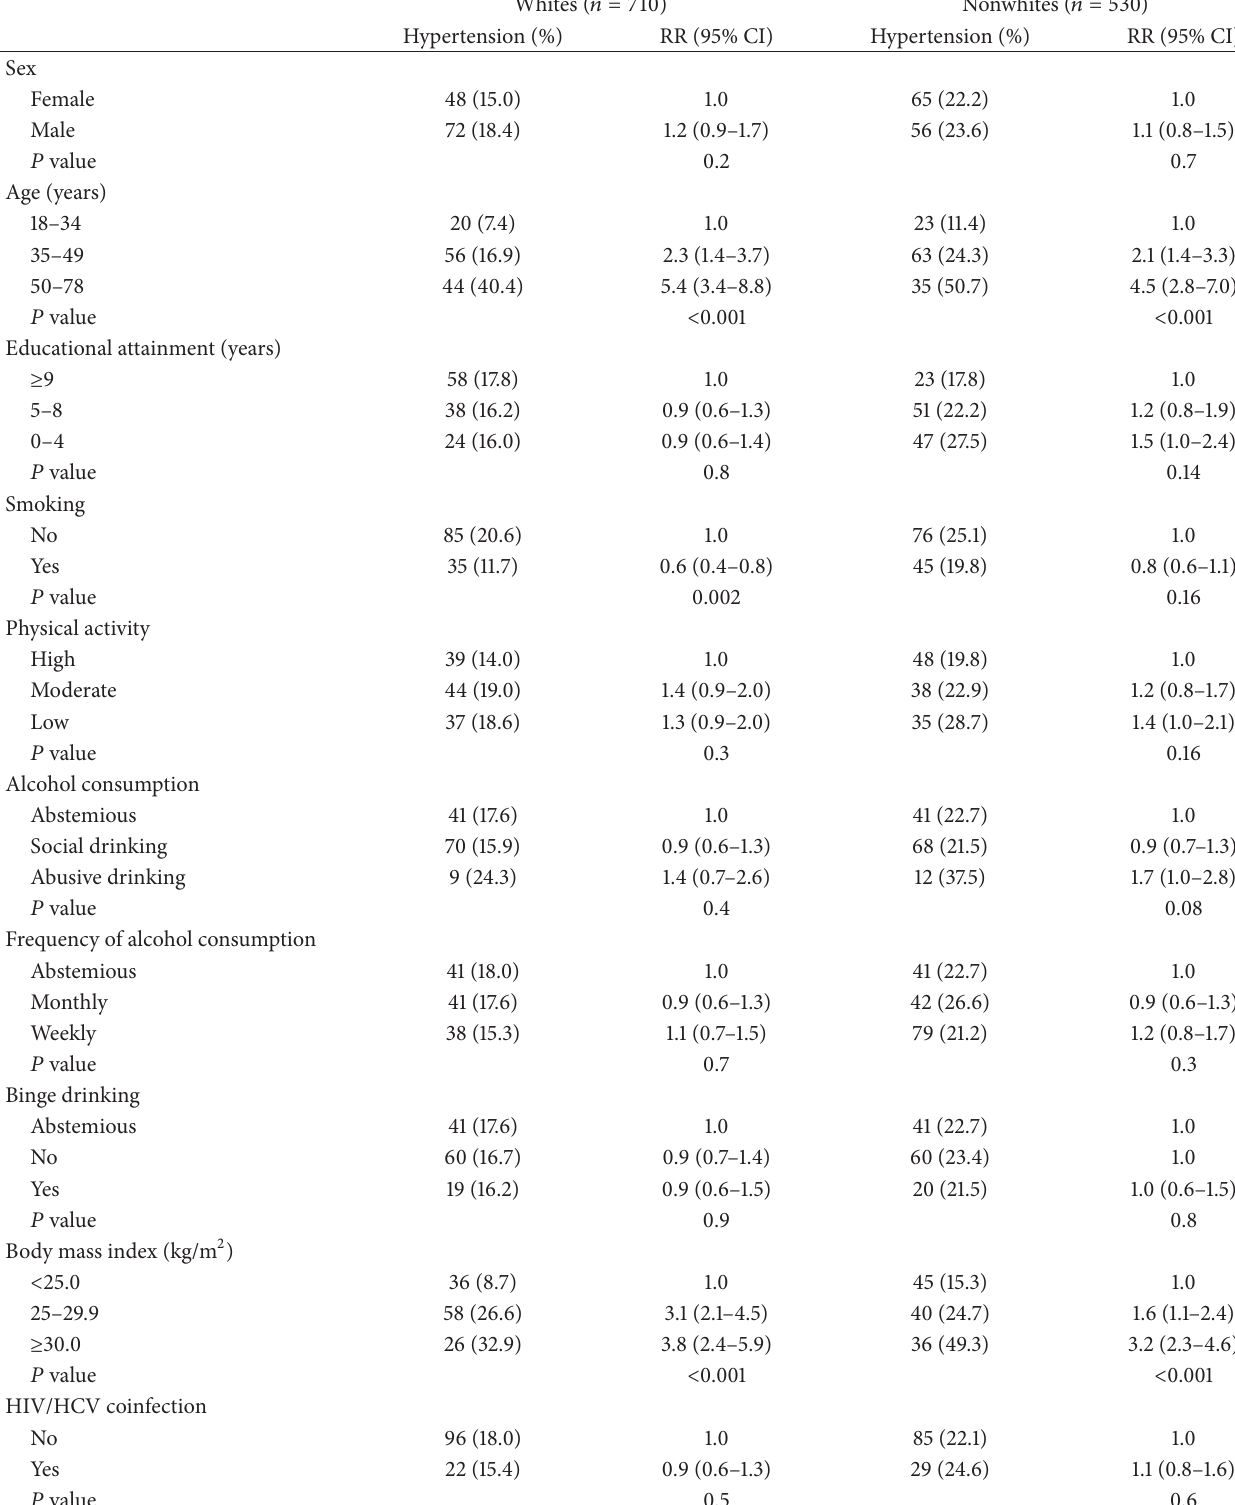
Table 2: Risk factors for hypertension among HIV-infected individuals by skin color ( 𝑛